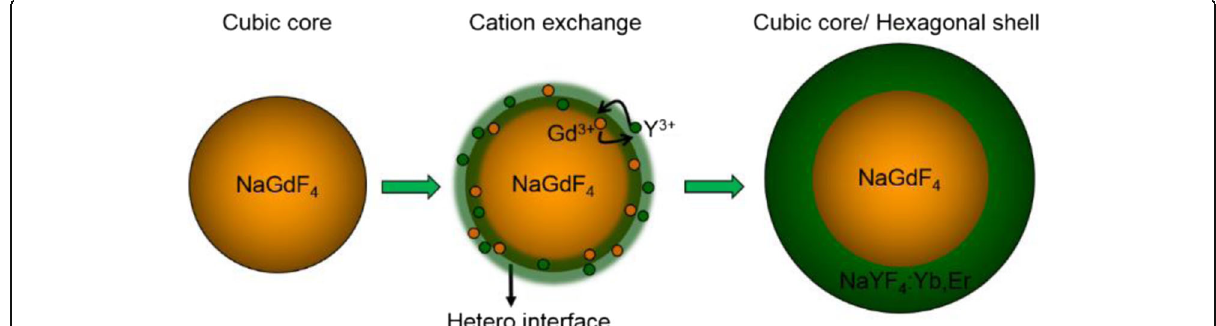
Fig. 1 Schematic diagram of growth process of heterogeneous core/shell nanocrystals